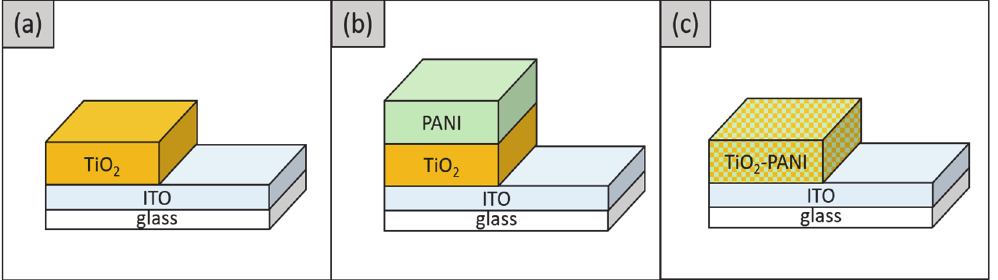
Figure 10. Cross ‐ section of ( a ) TiO 2 /ITO/glass, ( b ) PANI/TiO 2 /ITO/glass, and ( c ) TiO 2 ‐